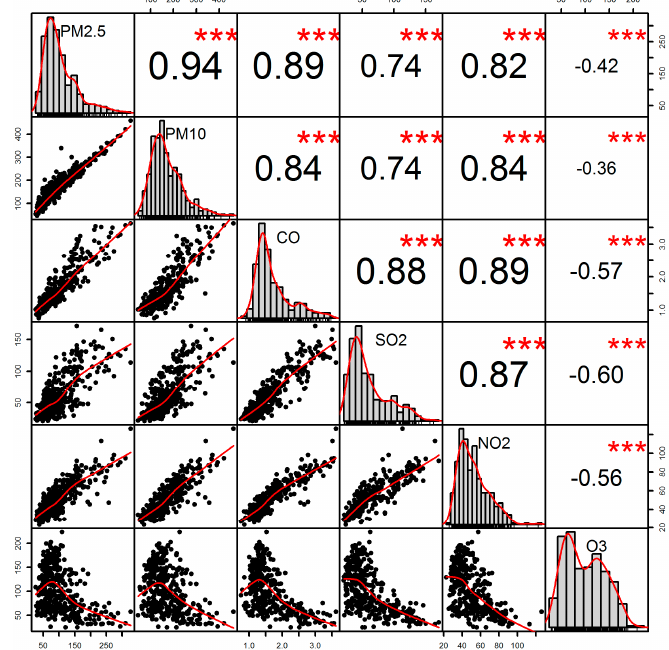
Figure 7. The relationships among the principal air pollutants in the 17 most polluted cities (2014). All the numbers and red stars represent the correlation coefficients and significant relationships among the principal air pollutants.